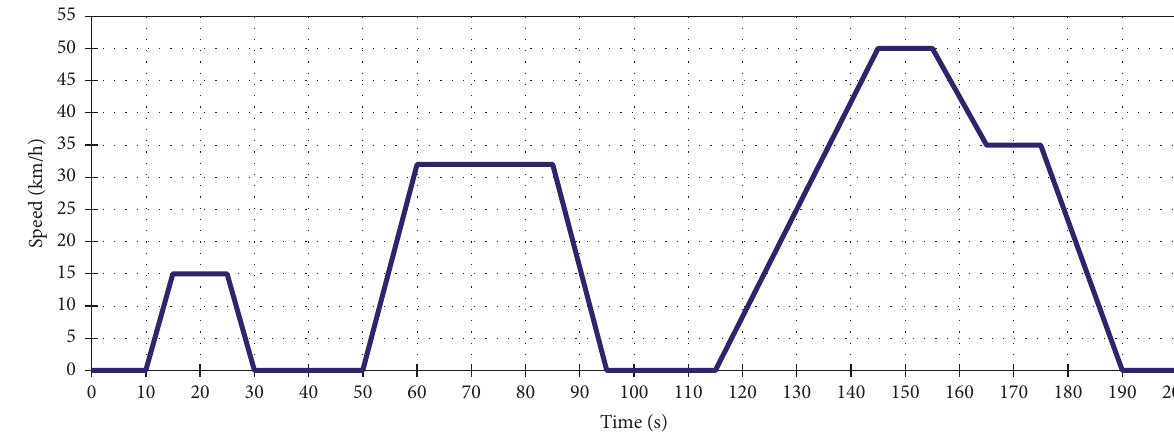
Figure 13: A typical city test cycle according to GBT 18386-2005.